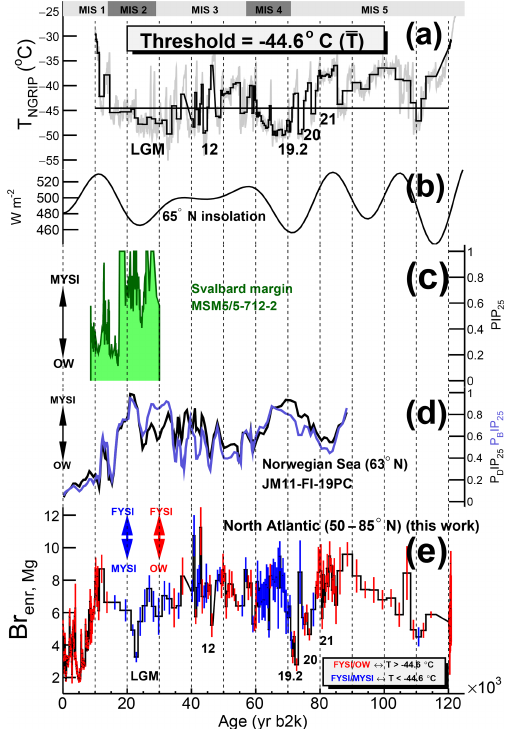
Figure 7. Discrimination between the two Br enr , Mg regimes ac- cording to the − 44 . 6 ◦ C NGRIP temperature threshold and North Atlantic sea ice records from marine cores. (a) Reconstructed NGRIP temperature (grey; Kindler et al., 2014). The temperature threshold value is the mean temperature during the 11.8–12.4ka pe- riod, when the change in Br enr , Mg regime was observed (see Fig. 6). The black series is the NGRIP temperature profile downscaled to the measured Br enr resolution. The numbers indicate the Greenland Interstadials (GIs) discussed in the text. (b) Daily mean insolation on 21 June at 65 ◦ N (Laskar et al., 2004). (c) PIP 25 record from the Svalbard margin (core MSM5/5-712-2 from Müller and Stein, 2014). (d) P D IP 25 and P B IP 25 90kyr records from the Norwegian Sea presented as five-point running mean (from Hoff et al., 2016). (e) Discrimination between the Br enr , Mg regimes computed accord- ing to the integrated temperature value with respect to the threshold. The FYSI/OW and FYSI/MYSI regimes are indicated with red and blue error bars